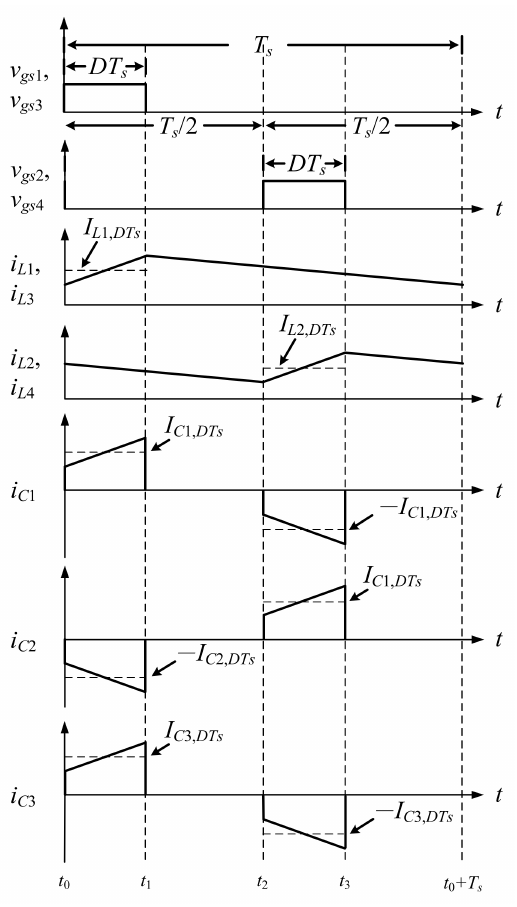
Figure 12. Current waveforms relevant to energy-transferring capacitors C 1 , C 2 and C 3